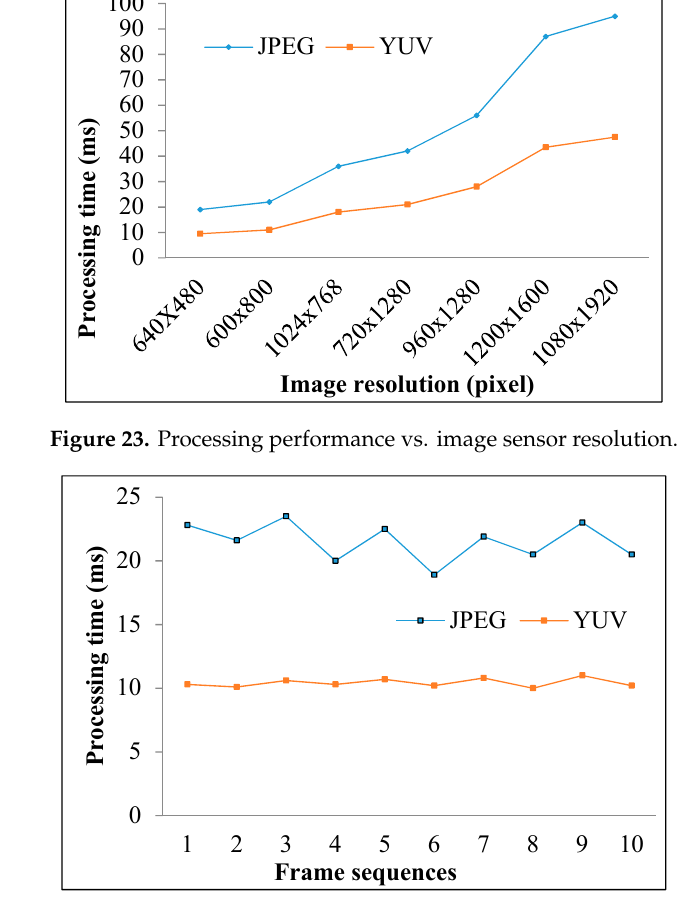
Figure 24. Processing performance vs. image type configuration.